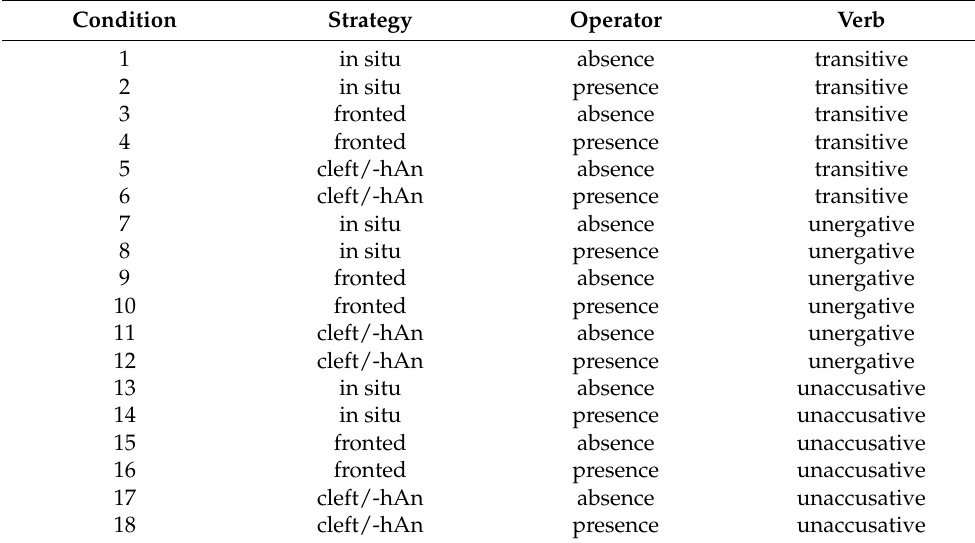
Table 1. Experimental